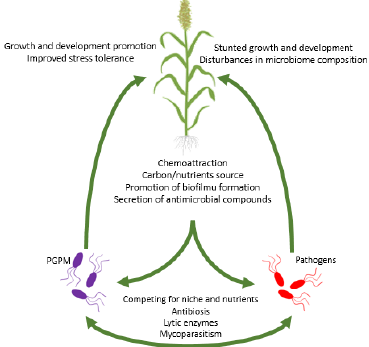
Figure 1. Multidimensional network of interactions between plants and PGPM, between plants and pathogens, and between PGPM and pathogens.